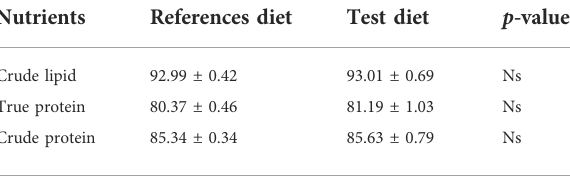
TABLE 4 Apparent digestibility coef fi cient (ADC%) of crude lipid, true protein, crude protein and amino acid of reference and test diets fed to Atlantic salmon.